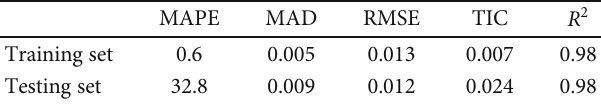
Table 7: Evaluation result of the LSTM